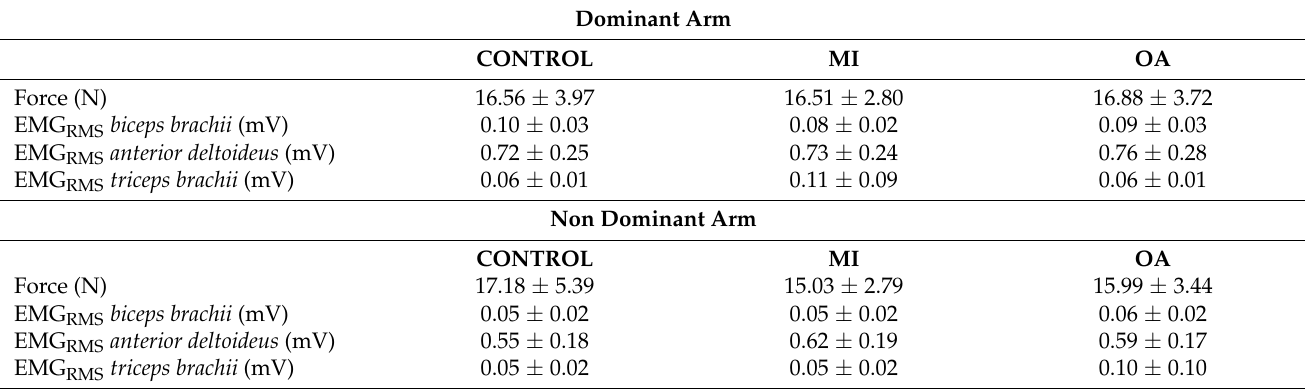
Table 1. Raw total force and EMG RMS data (Mean ± 95% CI) recorded during warm-up trials for each experimental session, for both